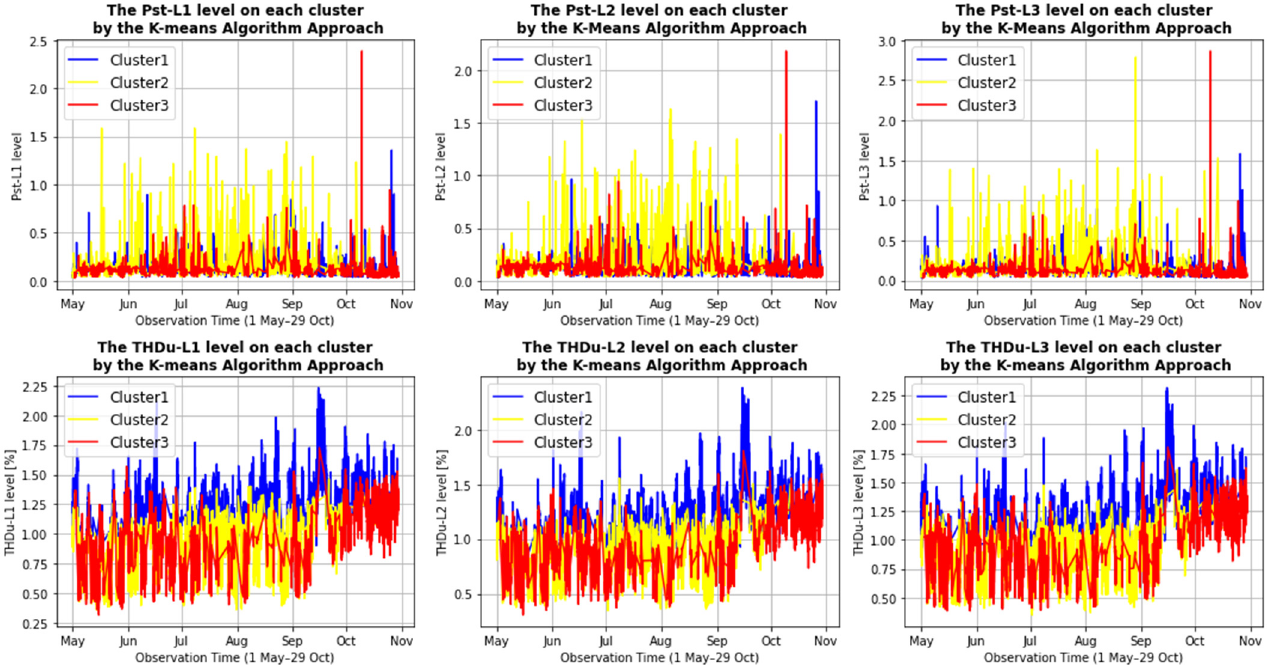
Figure 6. Visualization of PQ parameters’ level of the first investigation object at measurement points 2HPP-MV and 2ESS-MV by the K-means algorithm approach.